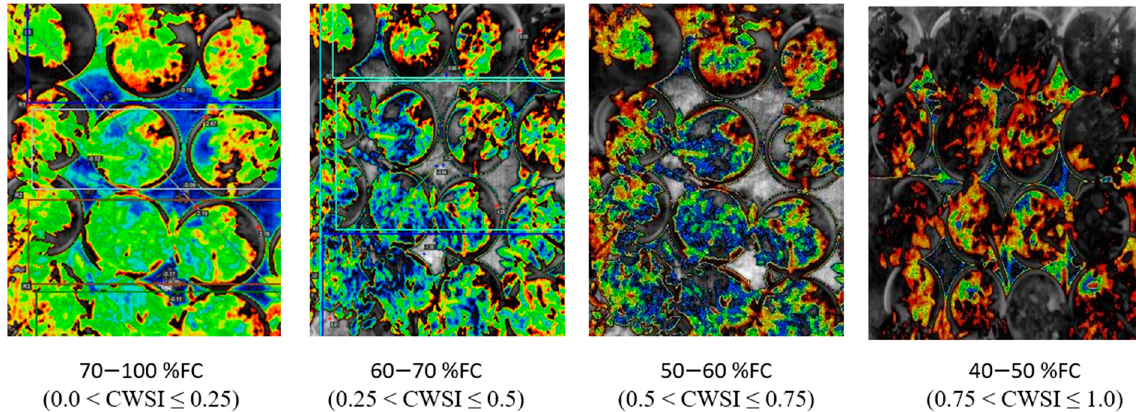
Figure 5. CWSI tiff images from WIRIS CorePlayer at different CWSI modes. ( a ) Empirical mode, ( b ) theoretical mode, and ( c ) differential mode revealing water stress with color mapping in tomato plants.